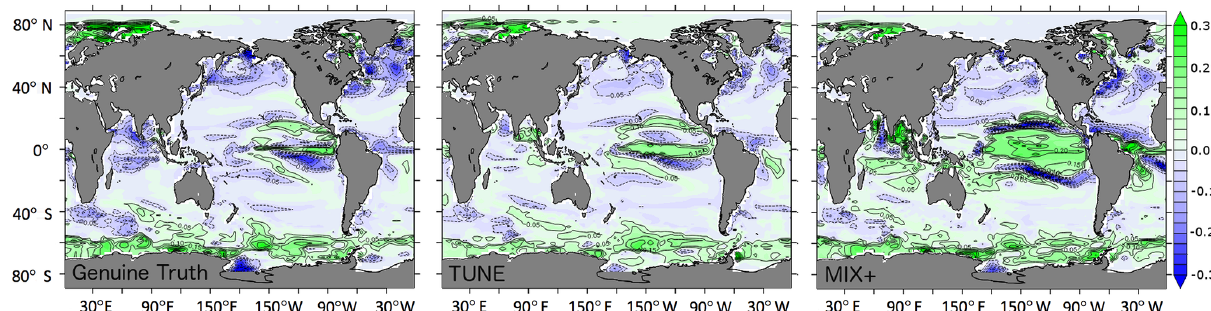
Figure 9. Simulated changes in surface phytoplankton concentrations as a consequence of rising CO 2 concentrations (emission scenario RCP8.5) calculated as the annual mean concentration difference between the years 2100 and 1850 (mmolNm − 3 ).